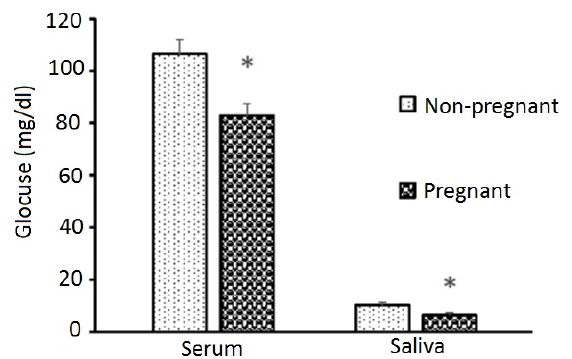
Figure 1 . Mean Serum and Salivary Glucose Concentrations in Pregnant and Non-pregnant Women. Note . * : A significant difference at P < 0.05.